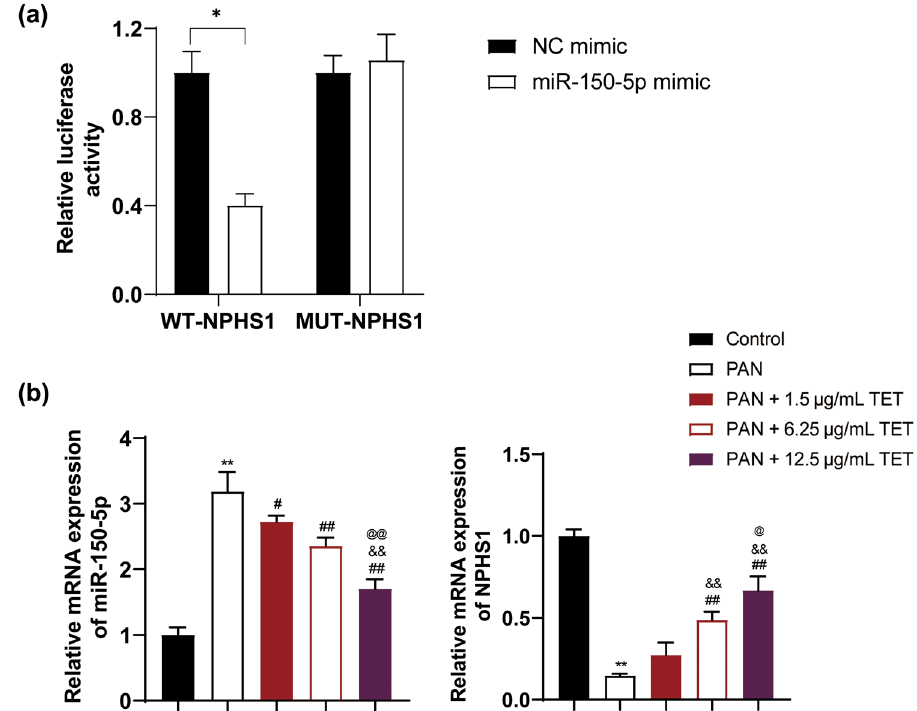
Figure 2: MicroRNA - 150 - 5p ( miR - 150 - 5p ) directly targeted NPHS1. ( a ) Dual - luciferase reporter gene assay detected the target relationship between the miR - 150 - 5p and NPHS1 ( * P < 0.05 ) . ( b ) RT - qPCR detected the expression of miR - 150 - 5p and NPHS1. PAN - induced HPC were treated with TET ( 1.5, 6.25, or 12.5 μ g/mL ) . ** P < 0.01 vs control group; # P < 0.05, ## P < 0.01 vs PAN group; && P < 0.01 vs PAN + 1.5 μ g/mL TET group; @ P < 0.05, @@ P < 0.01 vs PAN + 6.25 μ g/mL TET